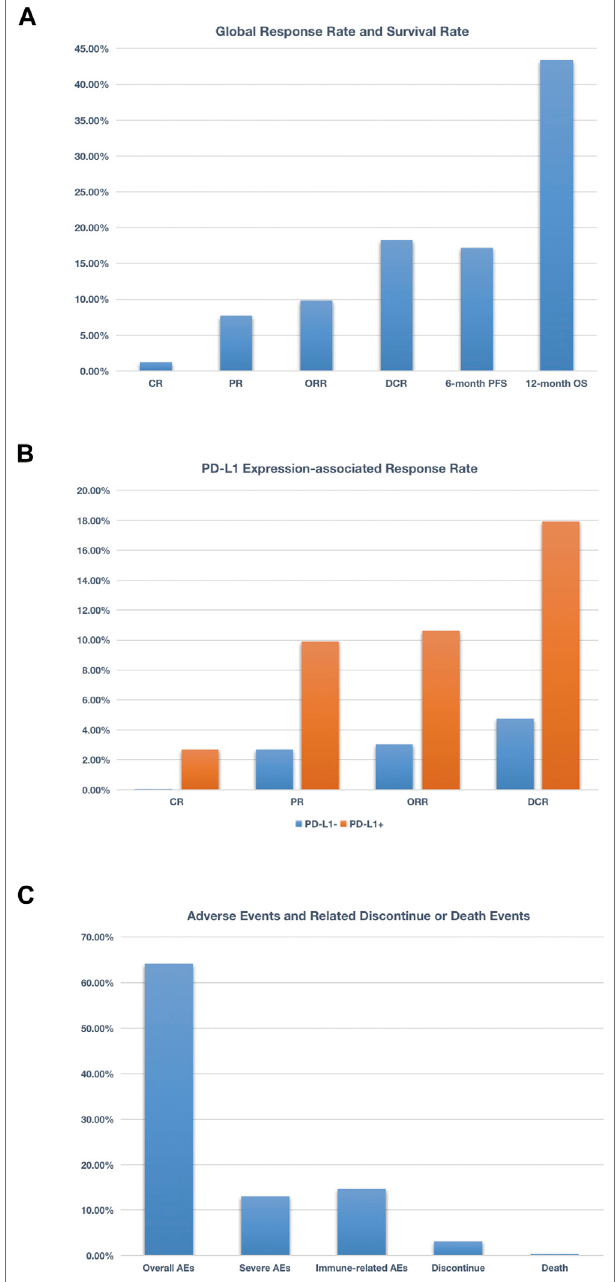
FIGURE8| Schematic fi gurerelatedtoglobalresponserateandsurvival rate (A) , schematic fi gure related to PD-L1 expression-associated response rate (B) , and schematic fi gure concerning adverse events and related discontinue or death events (C) . More than 17% patients could survive 6 months without disease progression, and over 43% patients could survive 1 year or more (A) ; when compared PD-L1+ with PD-L1 − patients, the CR was2.52vs0.00%,thePRwas9.93vs.2.69%.Additionally,PD-L1+patients even have approximately 3 times ORR and 3.6 times DCR of PDL1 − patients (B) ; nearly 65% patients treated with anti – PD-1/PD-L1 agents experienced at least one adverse event, and 13% patients suffered from at least one grade 3 or higher adverse event. As for irAEs, nearly 15% patients experienced one irAEs (C)